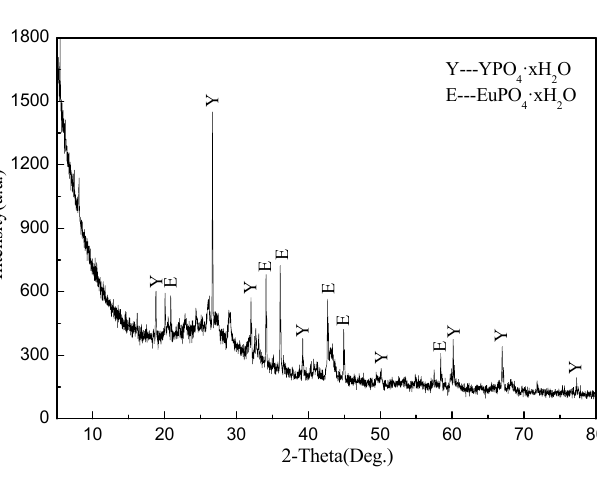
Figure 8. The XRD pattern of the RE solid precipitation.